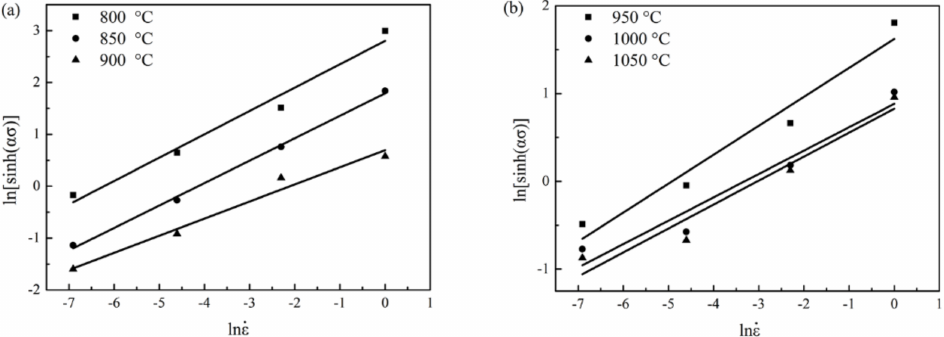
. ε for ( a ) 800–900 ◦ C and ( b ) 950–1050 ◦ C.